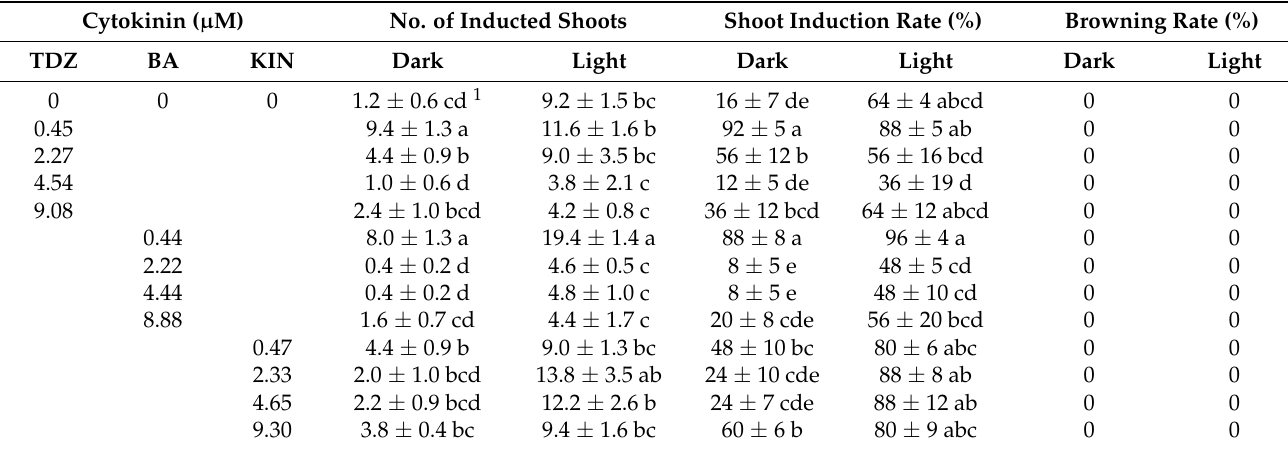
Table 6. Effect of thidiazuron (TDZ), 6-benzylaminopurine (BA) and kinetin (KIN) on shoot regeneration from strawberry ( Fragaria vesca ) callus explants after 2 weeks of culturing.